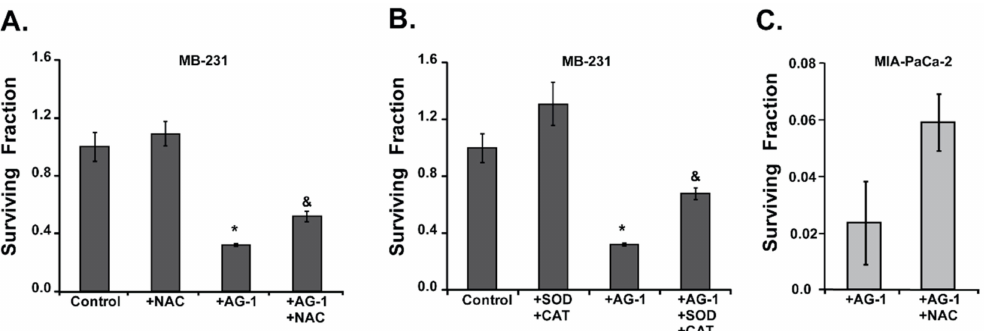
Figure 9. Oxidative stress regulates artemisinin dimer (AG-1)-induced cytotoxicity. ( A ) Pre-treatment with a thiol-antioxidant suppresses AG-1-induced cytotoxicity. Asynchronous cultures of MB-231 cells were pre-treated for 3 hours with 5 mM NAC (N-Acetyl-L-Cysteine) and then treated for 72 hours with 200 µ M of AG-1. ( B ) Antioxidant enzymes inhibit AG-1-induced cytotoxicity. Asynchronous cultures of MB-231 cells were pre-treated for 3 hours with polyethylene glycol conjugated catalase (500 units mL − 1 ) and superoxide dismutase (50 units mL − 1 ) and then incubated with 200 µ M of AG-1. ( C ) MIA PaCa-2 cells were treated with 5 mM NAC 3 hours prior to treatment with 5 µ M AG-1. A clonogenic assay was used to measure cytotoxicity. Asterisks represent significance compared to untreated control cells; n = 3, p < 0.05. Ampersand (&) represents significance compared to cells that were treated with